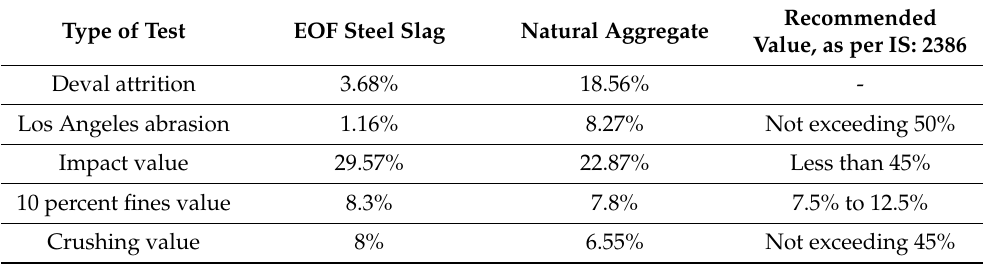
Table 4. Mechanical properties of coarse